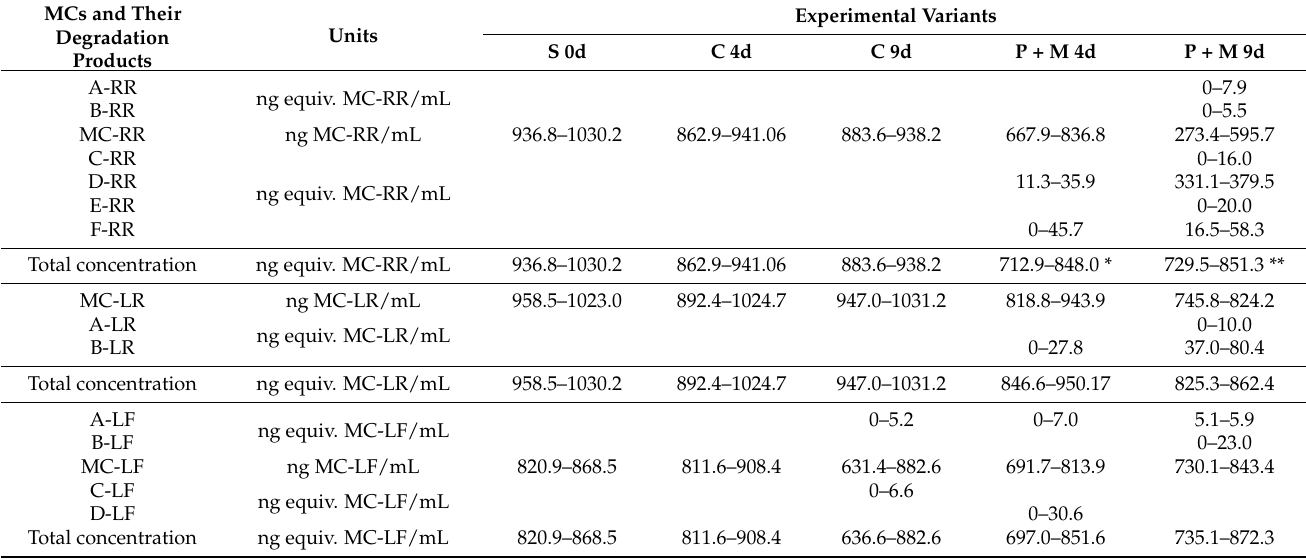
Table 2. Minimal and maximal concentrations of residual MCs and biodegradation products of MC-RR, MC-LR, and MC-LF after four and nine days of incubation with S. polyrhiza and associated microorganisms. S—experimental starting point; C—controls containing MCs, but without plants; P + M-–experimental variants with MCs, plants, and associated microorganisms.